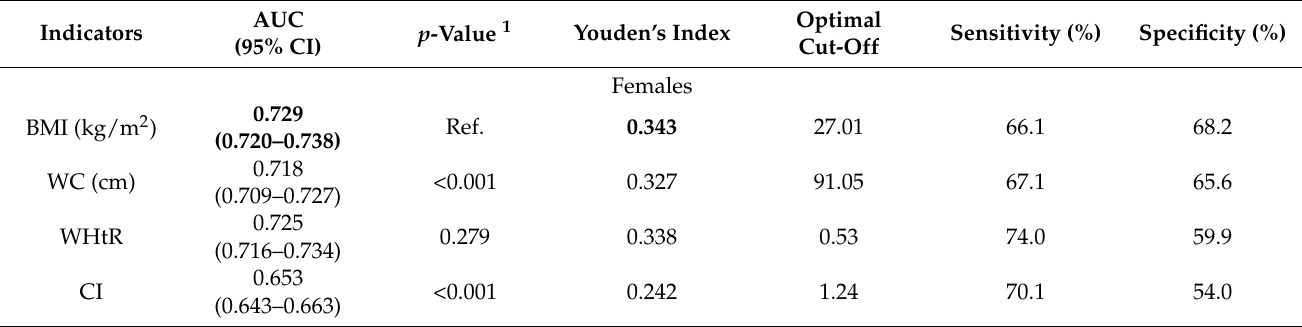
Table 3. Performance of the four anthropometric indicators as predictors of hypertension from ROC curve analysis in the unweighted sample.